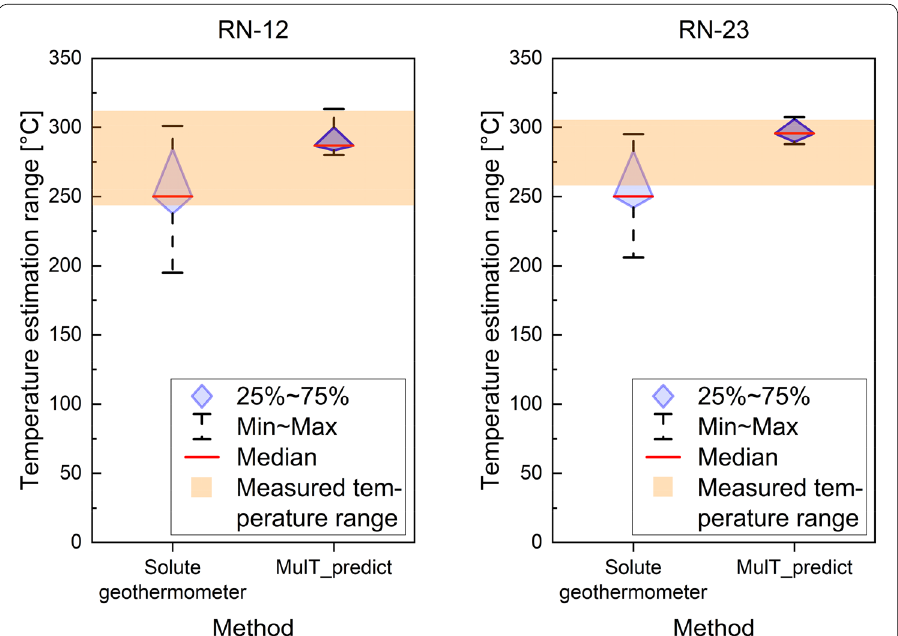
Fig. 12 Comparison of conventional qualitative solute geothermometers based on back-calculated element concentrations using WATCH 2.4 (Bjarnason 2010) (cf. Appendix 4) with the end results of MulT_predict (Fig. 10) for the wells at